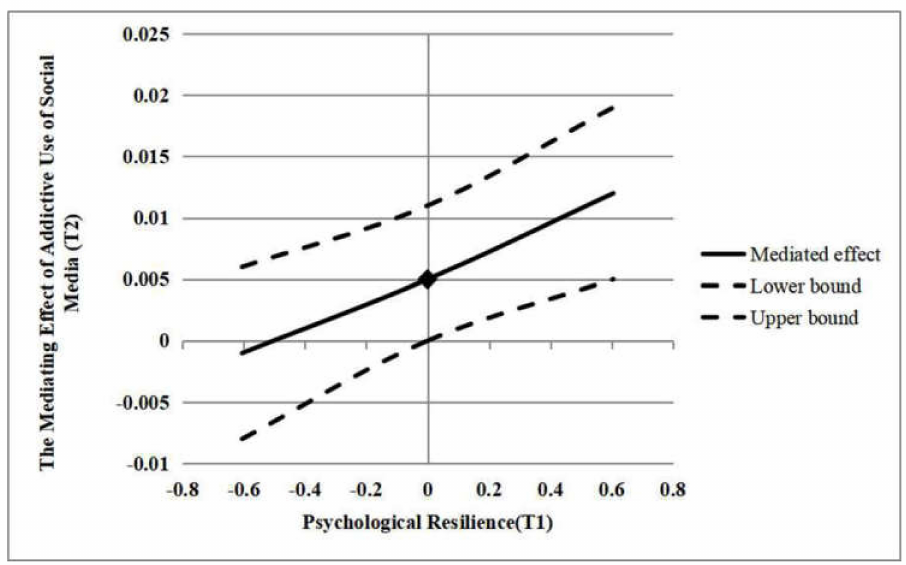
Figure 2. The mediating e ff ect of addictive use of social media (T2) at di ff erent levels of psychological resilience (T1).